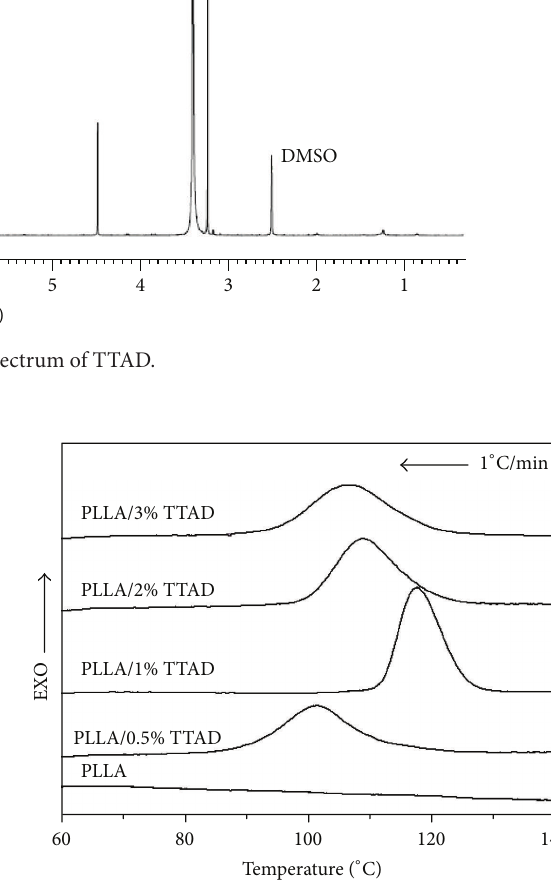
Figure 3: The DSC curves of nonisothermal crystallization from melt at different cooling rates.